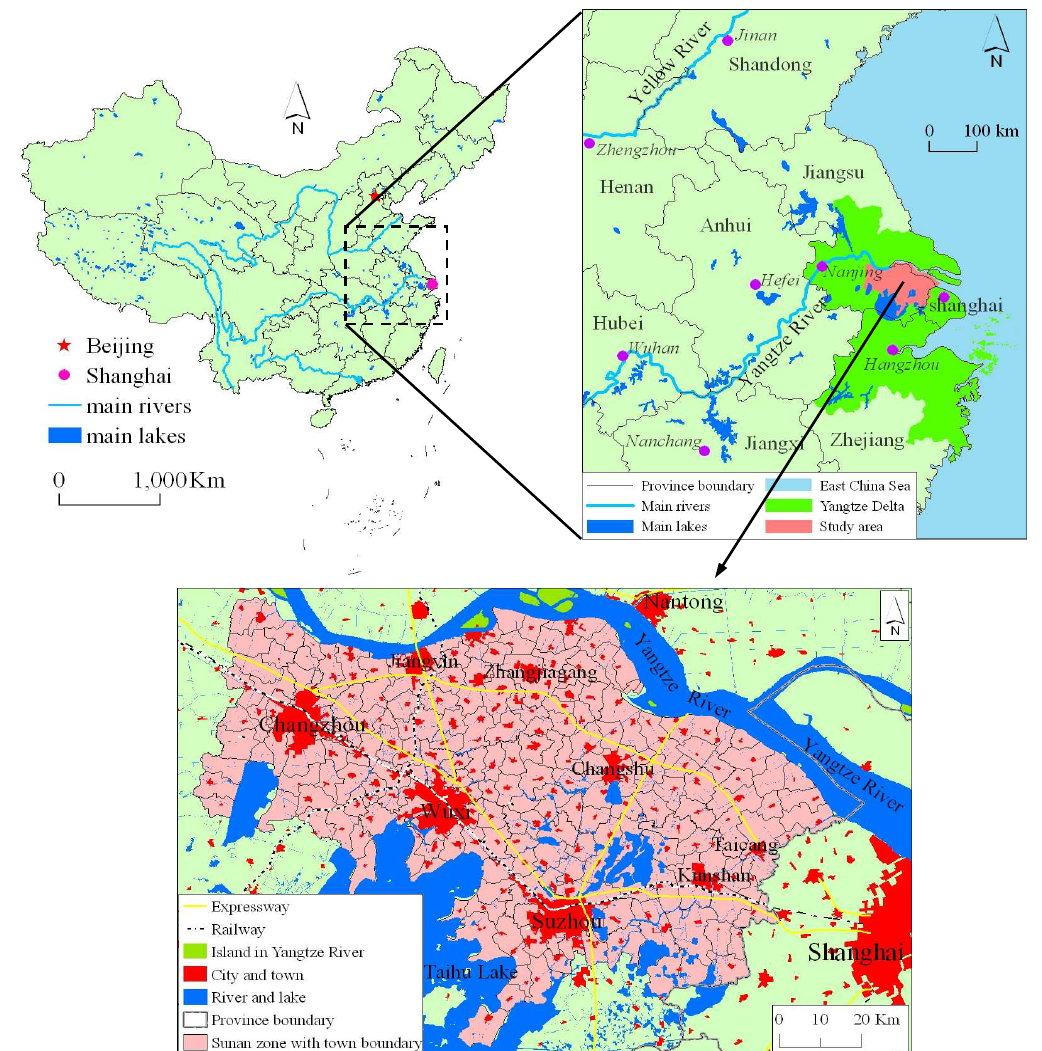
Figure 1. Location of the study area in